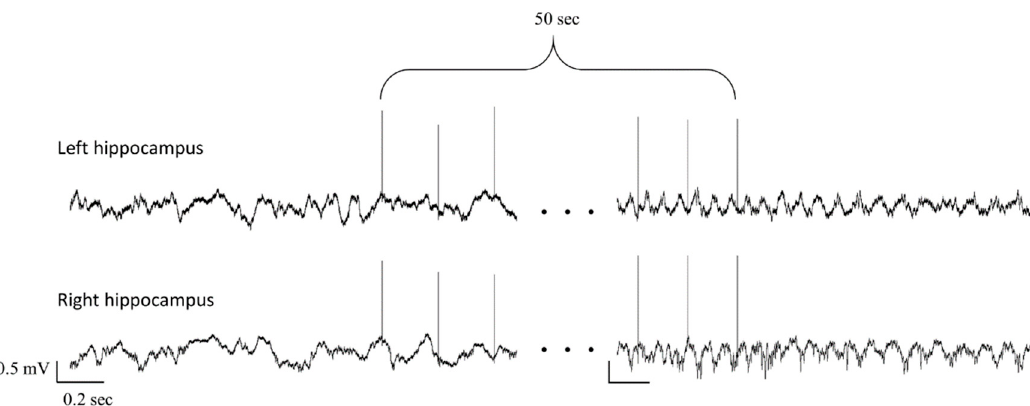
Figure 4. Local field potential (LFP) of the 2 hippocampi before and after a stimulation train. Only the first and the last three stimuli of the train are shown. Note the irregular activity before stimulation, while at the end of the stimulation 5–6 Hz regular LFP can be seen.